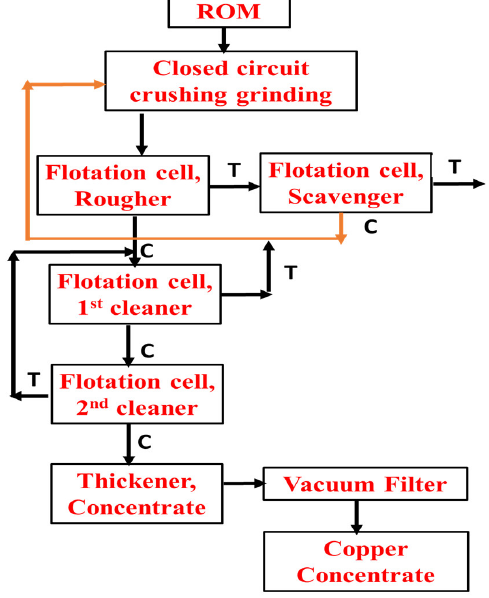
Figure 25. Malanjkhand copper concentrator plant flow sheet (India) [156].